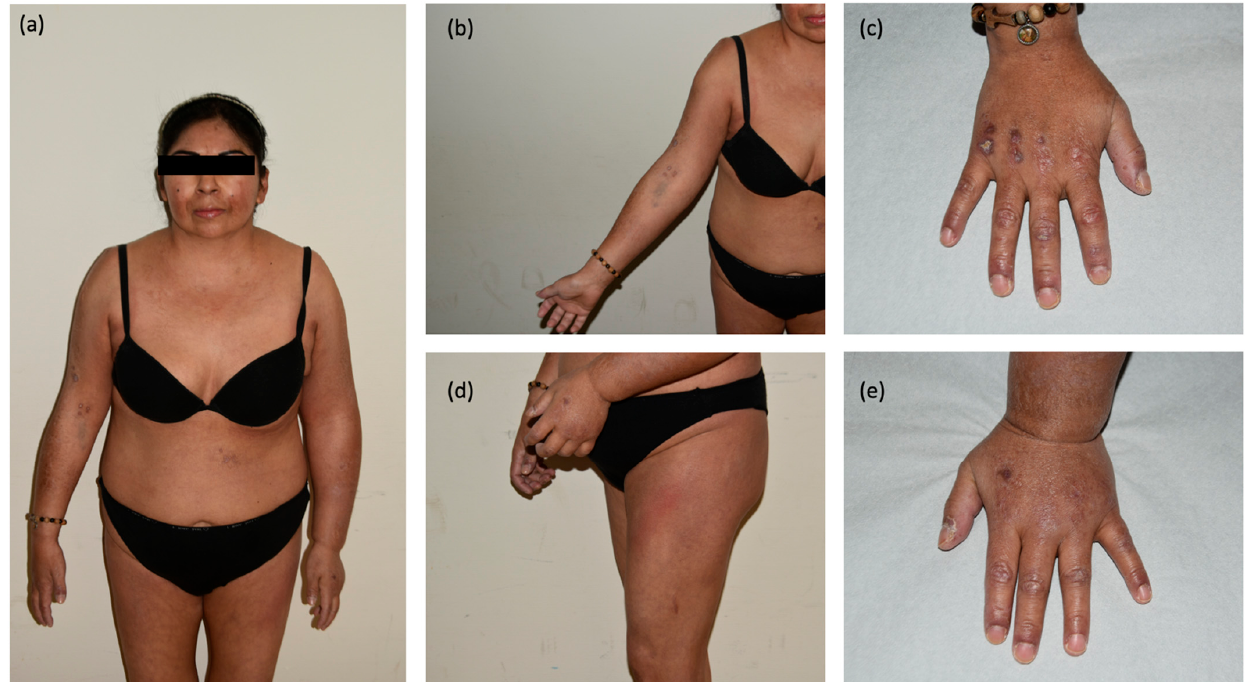
Figure 1. Clinical pictures of the patient at first medical contact: ( a ) full body photograph showing asymmetric edema mainly involving the left arm; ( b ) cutaneous ulcers over the right arm; ( c ) detail of the right hand showing Gottron’s papules and dystrophic cuticles; ( d ) Holster’s sign of the left tight; ( e ) detail of the left hand showing conspicuous edema.